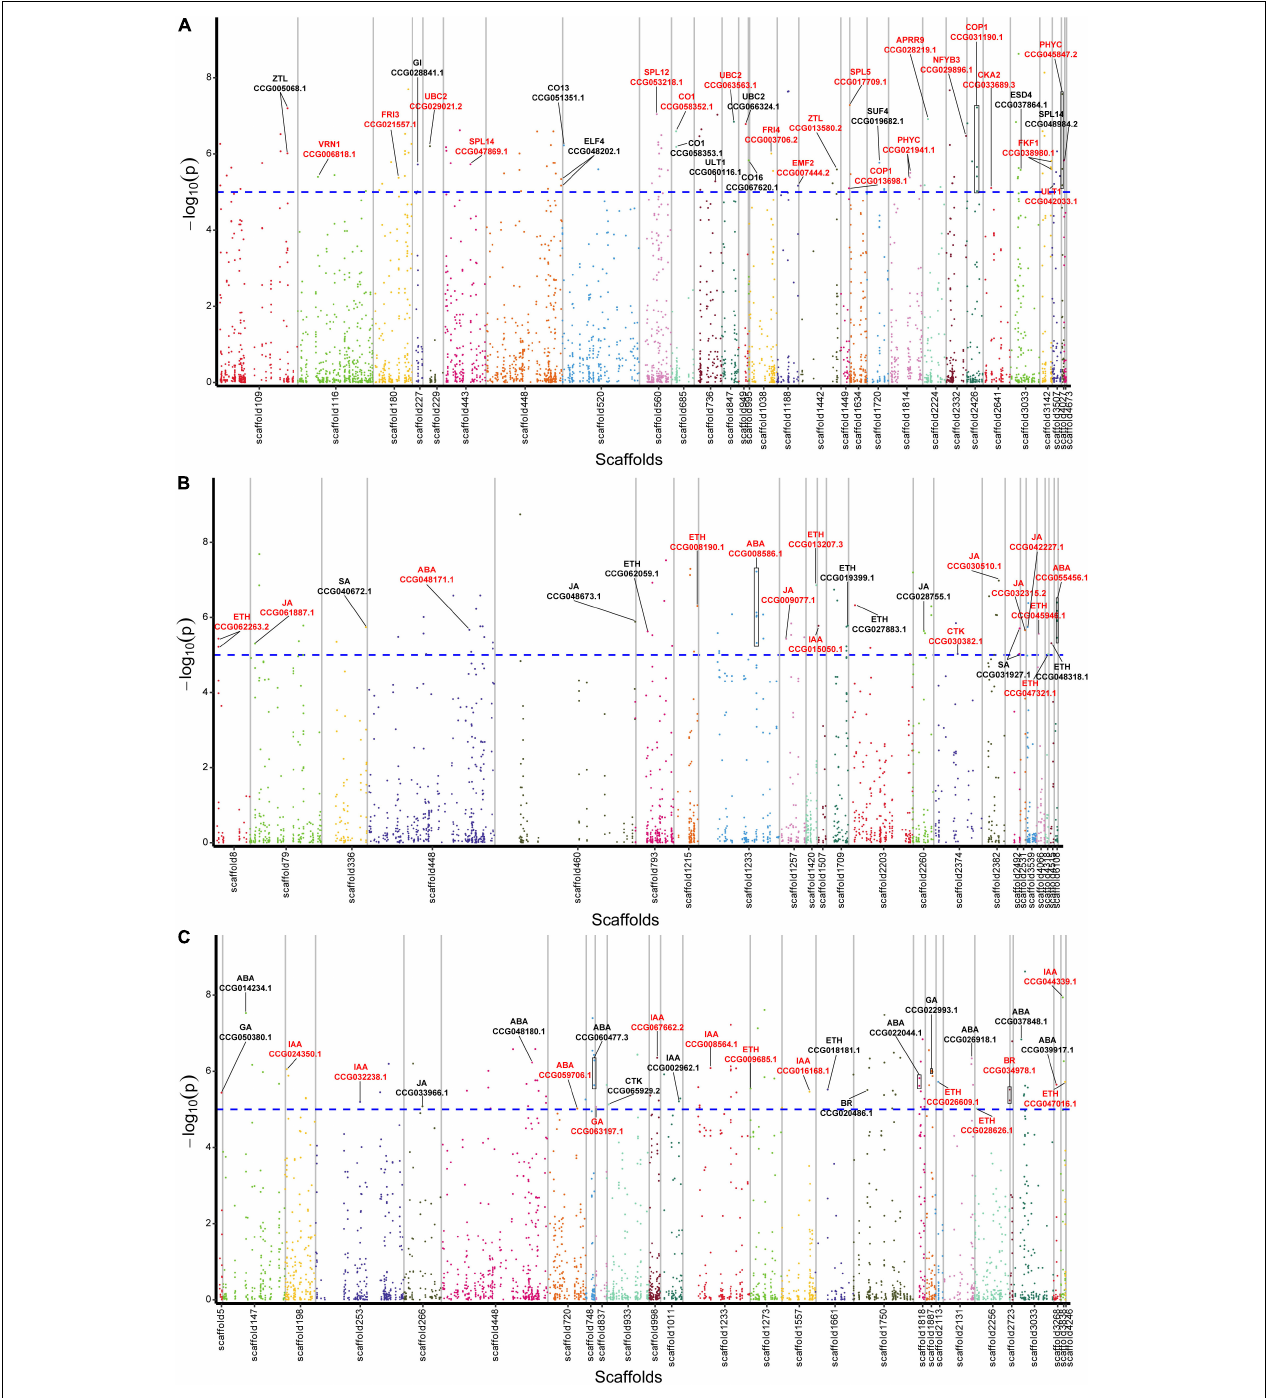
FIGURE 2 | Manhattan plot displaying the location of lead SNPs corresponding associated genes. (A) Flowering-related AGs. (B) Plant hormone biosynthesis-related AGs. (C) Plant hormone signal transduction-related AGs. The AGs are indicated with black lines, and the CAGs are marked by red color. Horizontal dashed line indicates significance threshold of log 10 ( p -values) =